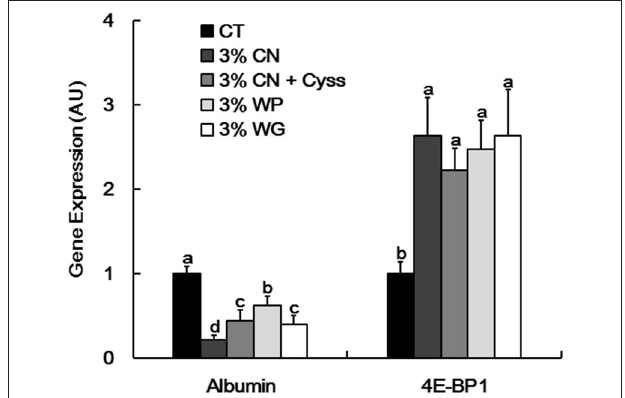
TABLE 3 | Energy intake, protein intake, body weight, and plasma free amino acid levels in Experiment 2. CT